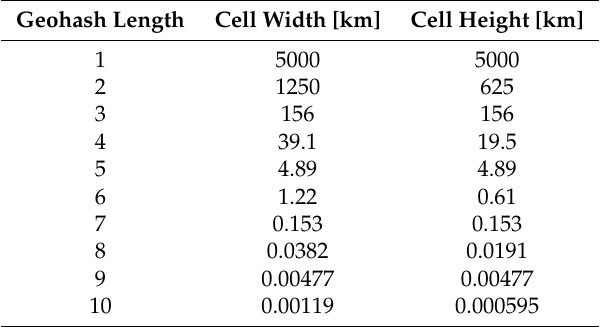
Table 1. Geohash length and its precision with geographic